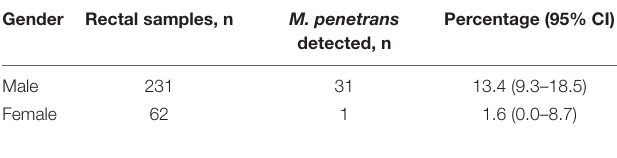
TABLE 1 | Distribution of M. penetrans among C. trachomatis positive rectal samples. Gender Rectal samples,